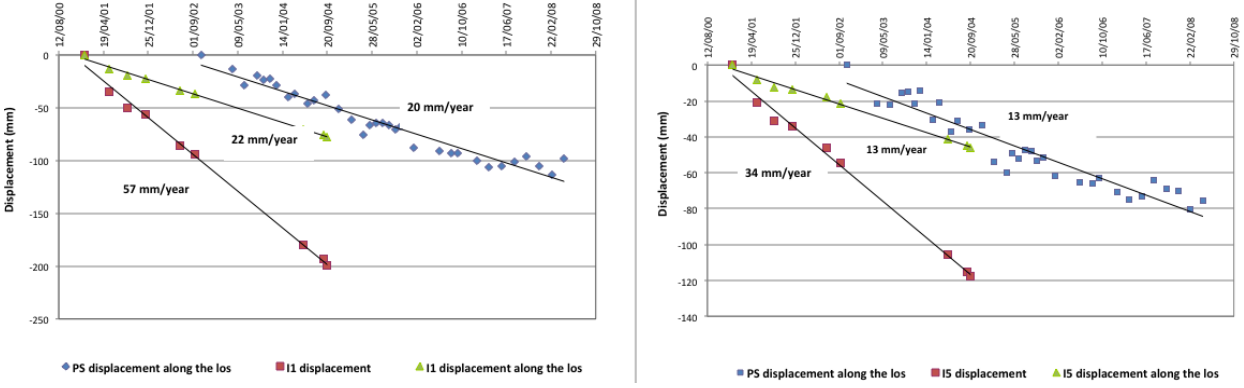
Figure 7. Comparison of PS ® and inclinometer time series of